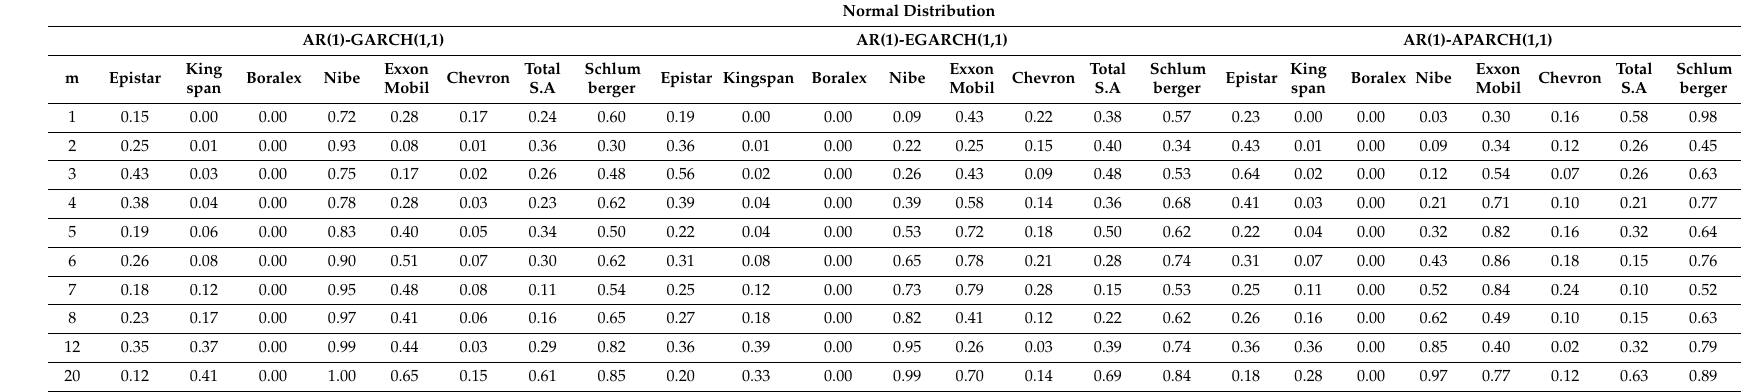
Table A7. Ljung-Box test of standardized squared residuals from AR(1)-GARCH(1,1), AR(1)-GARCH(1,1) and AR(1)-APARCH(1,1)